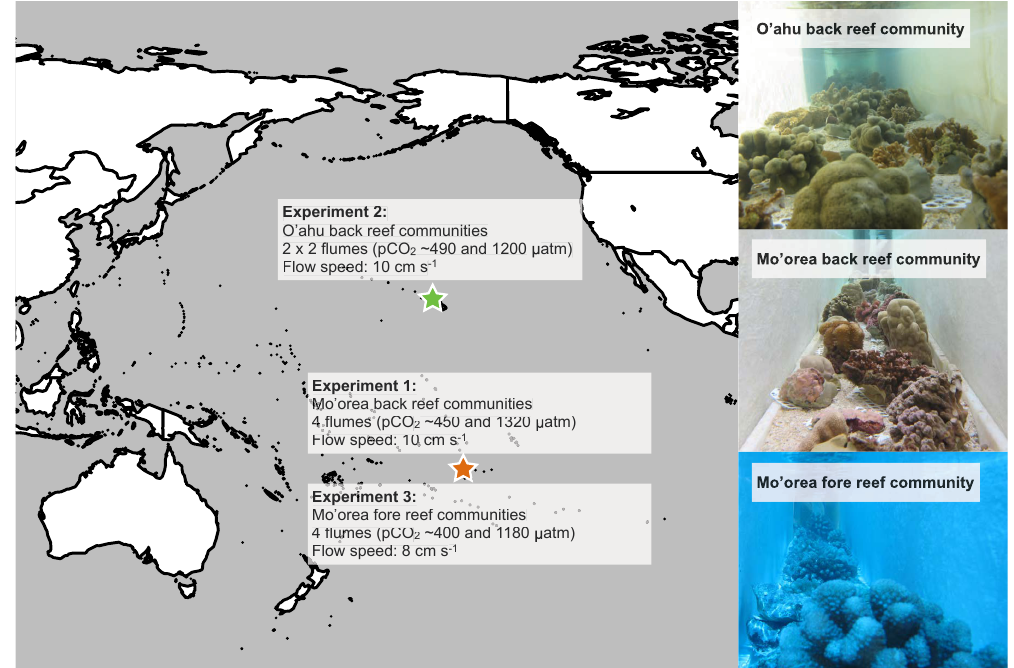
Figure 1. Map showing the study locations and photos of the three assembled communities. Experiments were performed on three coral reef communities representing the back reef of Mo’orea (Experiment 1), the back reef of O’ahu (Experiment 2), and the fore reef of Mo’orea (Experiment 3). The respective p CO 2 levels and flow speeds used are